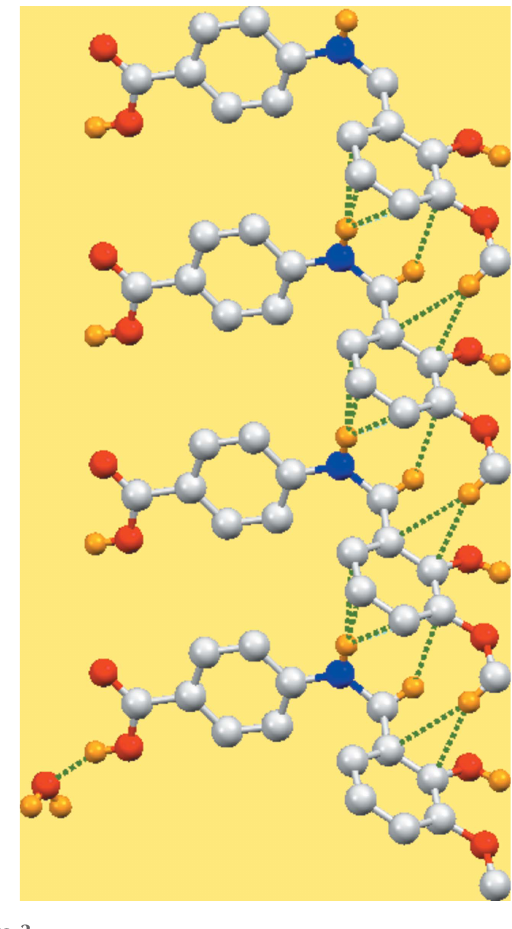
Figure 3 A view along the c axis of the zigzag chain in the crystal of the title compound. The N—H (cid:2)(cid:2)(cid:2) (cid:2) interactions are shown as dashed lines (see Table 1 for details).